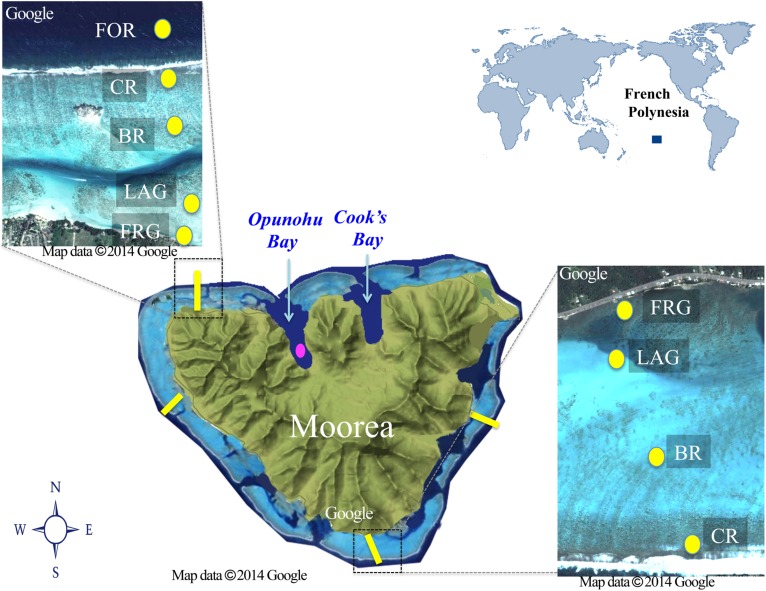
Map of the study area. Spatial samples were collected along four regional reef transects (east, west, south, and north; yellow lines). Each transect crossed distinct reef habitats: fringing reef (FGR), lagoon (LAG), back reef (BR), crest (CR), and fore reef (FOR); yellow dots. Note the FOR was sampled only on the north transect. Temporal samples were collected every 2–3 days for 21 days in a site in the Opunohu Bay (pink dot). Aerial views of the north and south transects are shown.